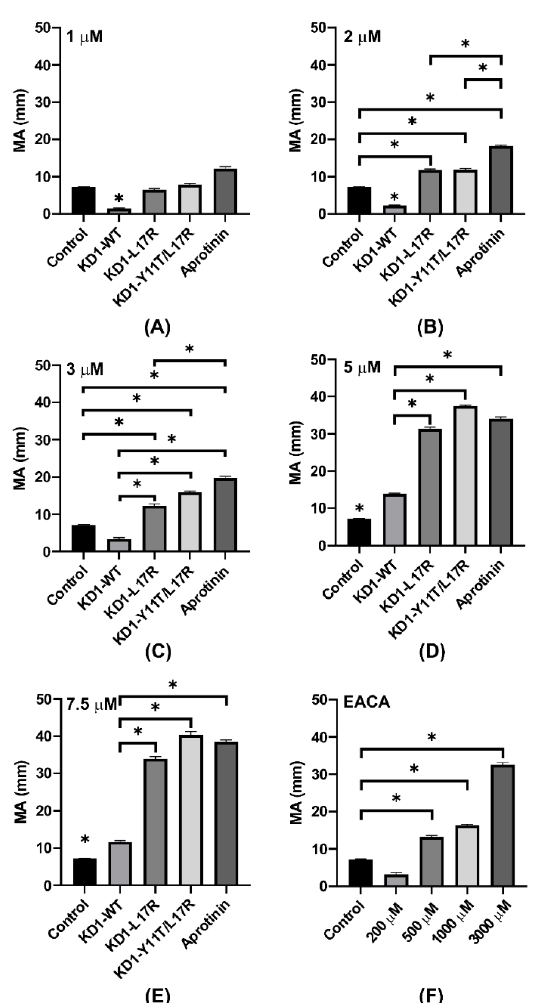
Figure 8. Comparison of maximal amplitude (MA) from the TEG experiments for KD1-WT, KD1-L17R-K COOH , KD1-Y11T/L17R-K COOH , aprotinin and EACA at different concentrations. Bar graphs represent the MA achieved with KD1-WT, KD1-L17R-K COOH , KD1-Y11T/L17R-K COOH , aprotinin and EACA at different concentrations. Panel A , 1 µM; panel B , 2 µM; panel C , 3 µM; panel D , 5 µM; panel E , 7.5 µM; and panel F , 200 M to 3000 M EACA. All experiments were performed in duplicate and the mean ± SD values are presented. Note: The * without bar represents significant difference from all other agents listed. The * indicates p < 0.05.